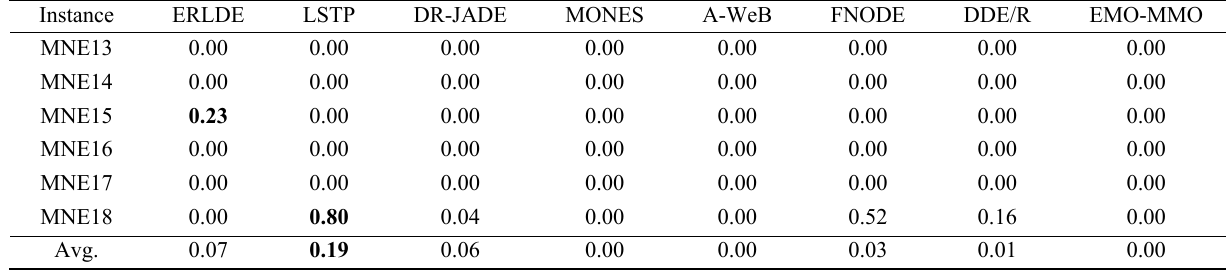
Table A8 Comparison of different algorithms on the new test set in terms of SR